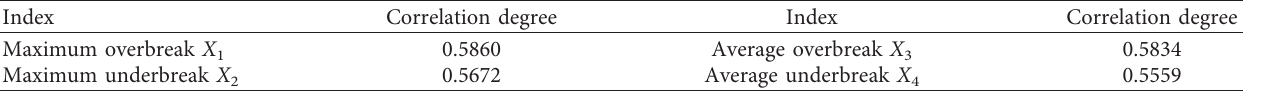
Table 4: Correlation degree of point indices.